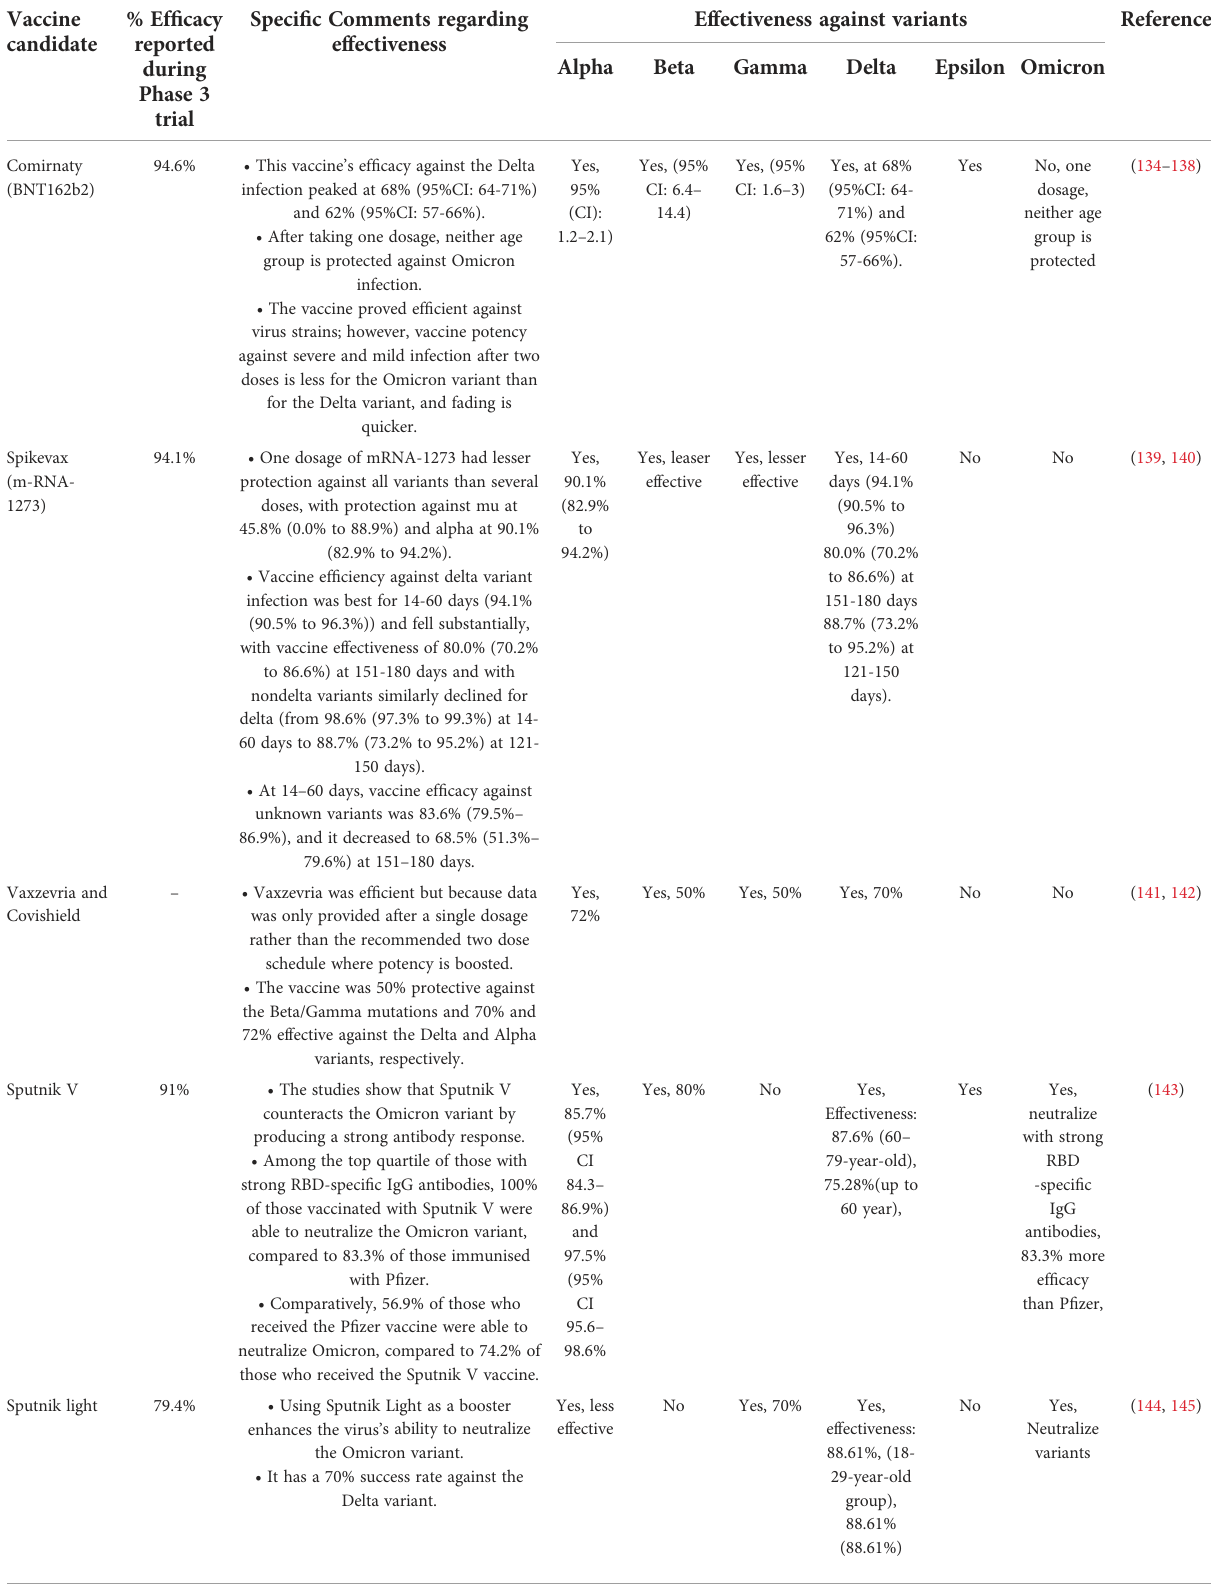
TABLE 2 Coronavirus variants and effectiveness of the current vaccines. Vaccine